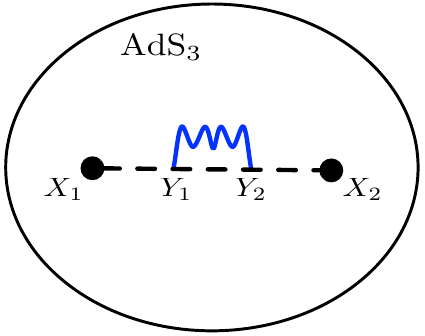
Figure 3 . This (cid:12)gure displays the scalar-graviton one-loop diagram that contributes to (cid:30) ( X 1 ) (cid:30) ( X 2 ) at order 1 =c . There is also a contact interaction, but the associated diagram vanishes. h i The computation is performed in appendix